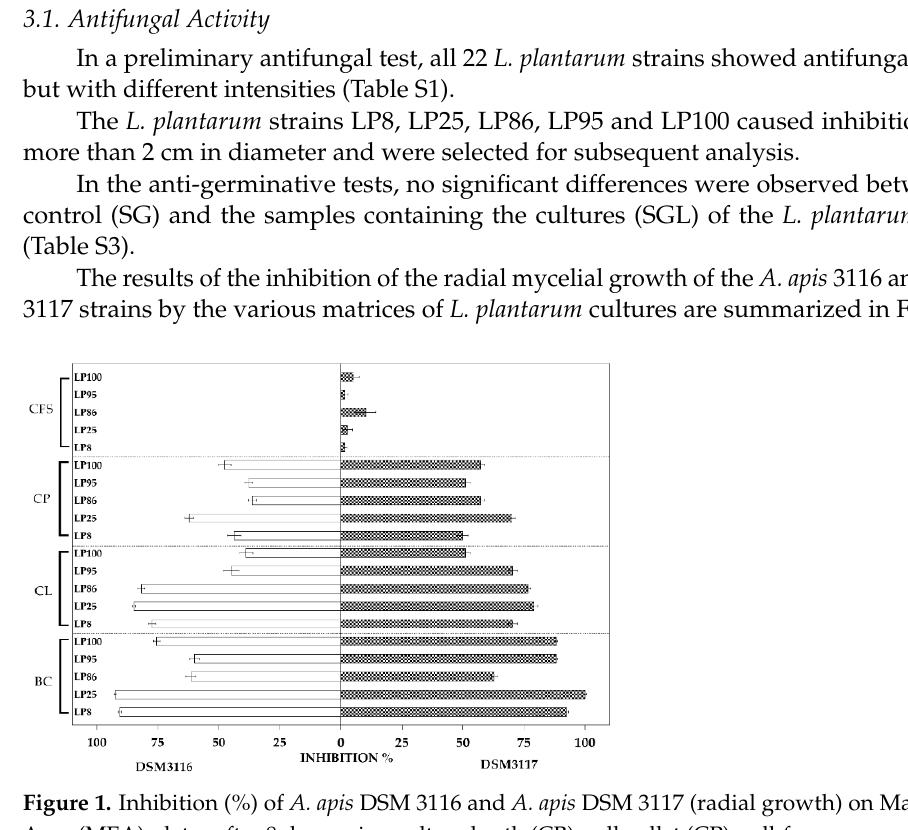
Figure 1. Inhibition (%) of A. apis DSM 3116 and A. apis DSM 3117 (radial growth) on Malt Extract Agar (MEA) plates after 8 days using culture broth (CB), cell pellet (CP), cell-free supernatant (CFS) and cell lysate (CL) from the L. plantarum strains.